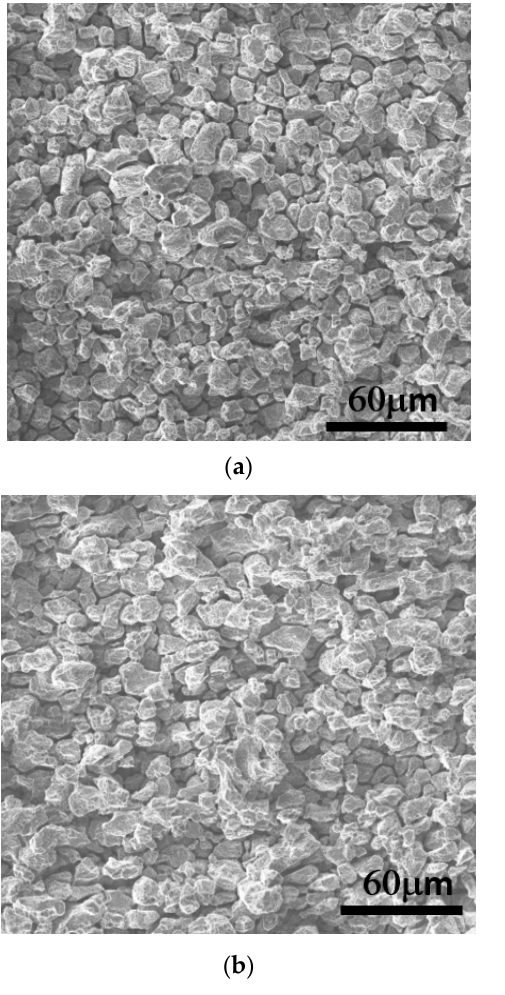
Figure 8. SEM morphology of alloy corrosion after sensitization: ( a ) alloy A annealed at 350 °C; ( b ) alloy B annealed at 350 °C; ( c ) alloy A annealed at 450 °C; ( d ) alloy B annealed at 450 °C.